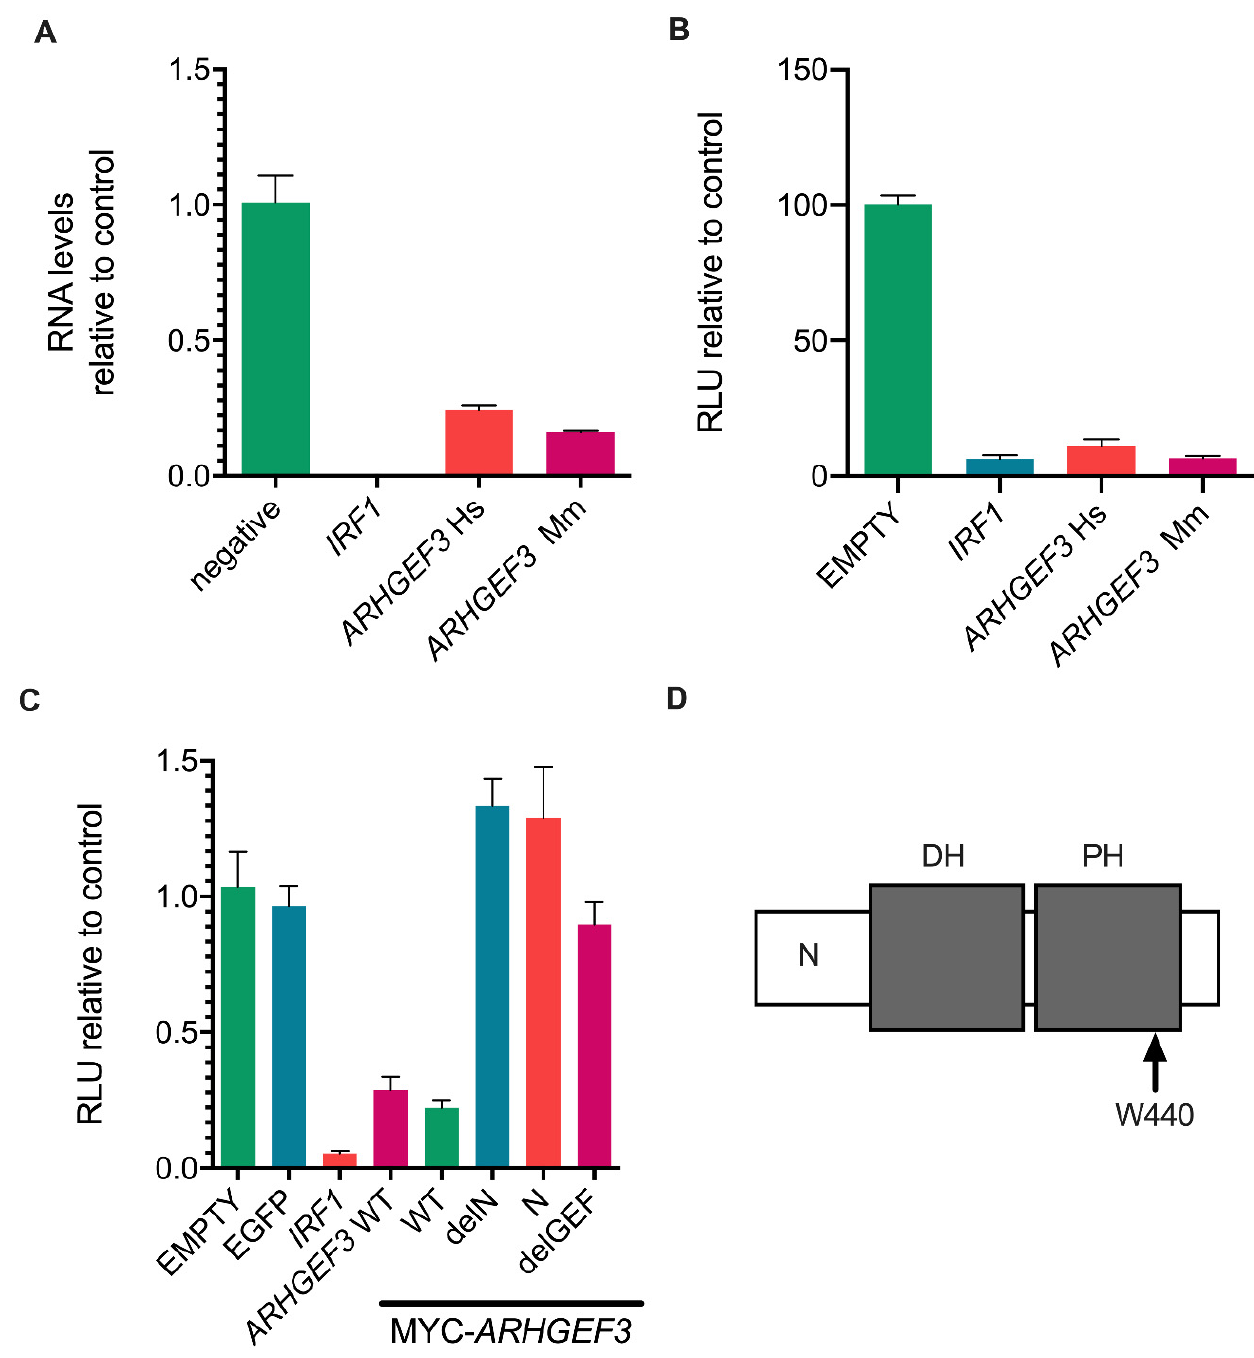
Figure 4. Validation of the antiviral activity of ARHGEF3/XPLN on HCV RNA replication. ( A ) Relative HCV RNA abundance from HCVcc infection of Huh7 cells expressing ARHGEF3 from Human (Hs) or rhesus macaque (Mm) as compared to negative control at 72 hpi. ( B ) Relative RLU (%) following HCV SGR RNA transfection of Huh7 cells expressing ARHGEF3 from Human (Hs) or rhesus macaque (Mm) as compared to negative control at 72 hpt. ( C ) Effect of ARHGEF3/XPLN -specific mutations (Myc-tagged WT, N-terminus truncation, N-terminus only and the GEF-inactivation mutant W440L) on HCV RNA replication following SGR RNA transfection. ( D ) Schematic of ARHGEF3 showing the N (amino acids 1–125), diffuse B cell lymphoma homology (DH) and plekstrin homology (PH) domains, alongside the location of the W440 residue. RLU activity was measured and compared to controls at 72 hpt. Values from combined three technical replicates from two independent experiments were used and variation is shown as standard error of the mean.